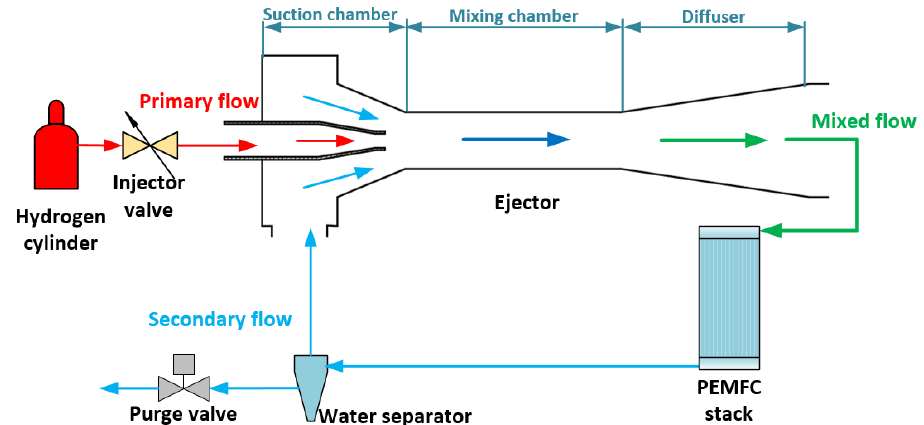
Figure 2. Schematic diagram of a typical ejector-driven hydrogen recirculation of PEM fuel cell systems.